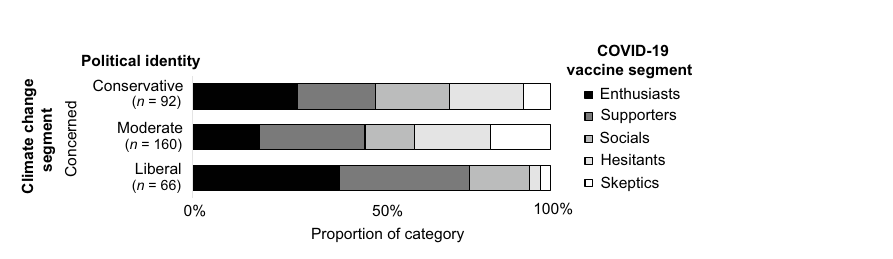
Figure 2. Vaccine segment distributions within the Concerned climate segment for men and women.